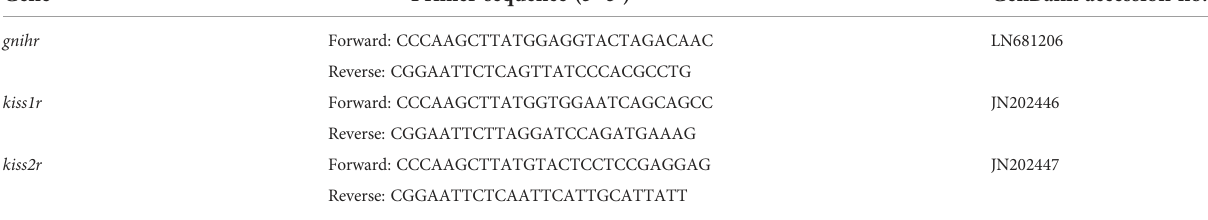
TABLE 1 Primer list for construction of